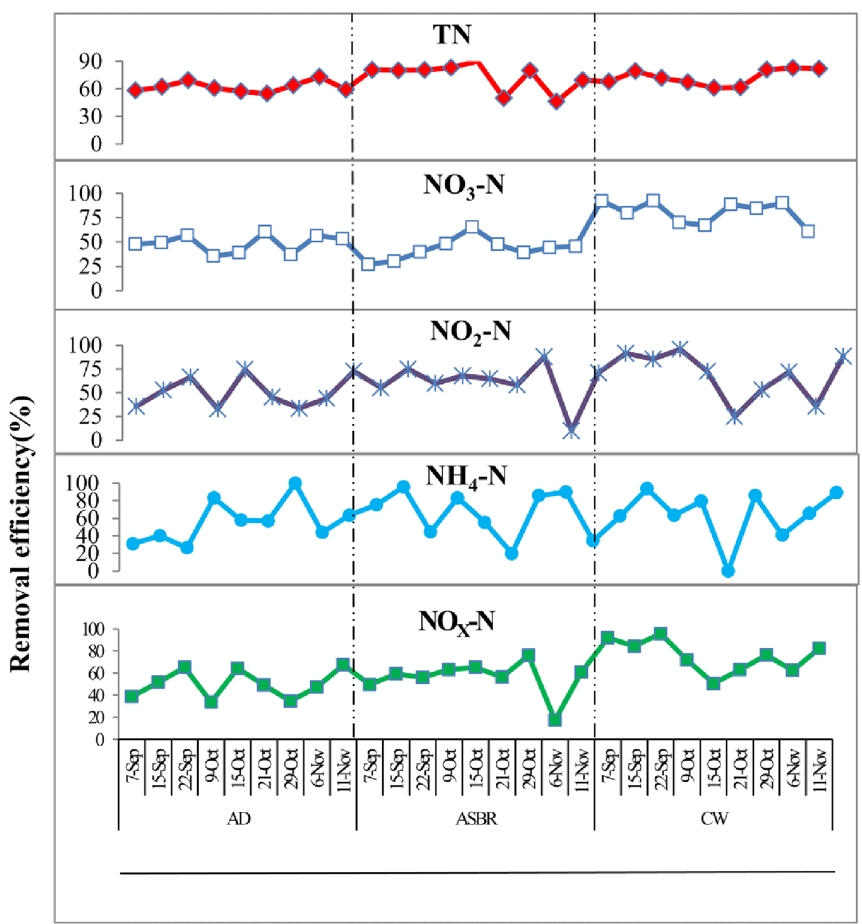
Fig. 6 Changes in the con- centration of TN and different forms of nitrogen in each unit